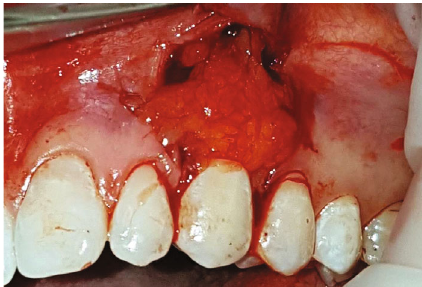
Figure 9: Macerated portion of the buccal fat pad cover of the recipient site.